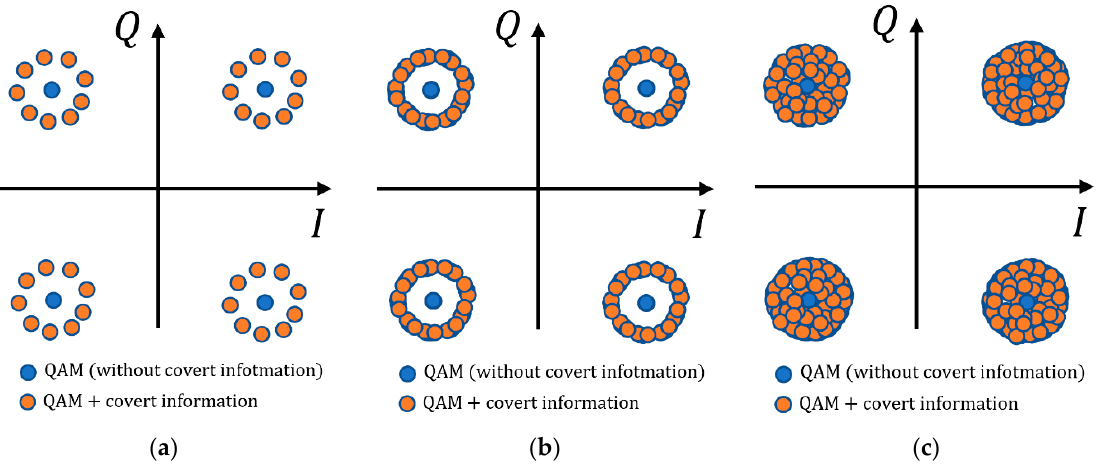
Figure 4. Constellations of carrier and the covert channels applied with: ( a ) fixed initial phase φ x ; ( b ) random φ x ; and ( c ) random φ x and A m .